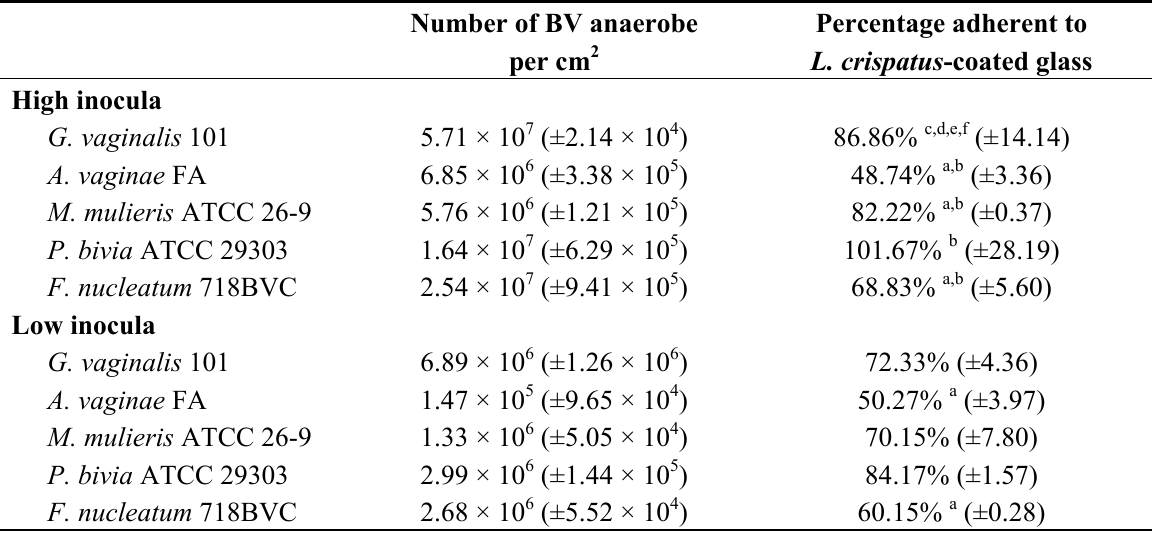
Table 1. Blockage of adherence of bacterial vaginosis (BV)-associated anaerobes to glass by adherent L. crispatus . The number of each BV-associated anaerobes that adhered per cm 2 of glass (±standard deviation) is shown on the left and the percentage of bacteria that adhered when the glass was pre-coated with L. crispatus relative to the control (±standard deviation) is shown on the